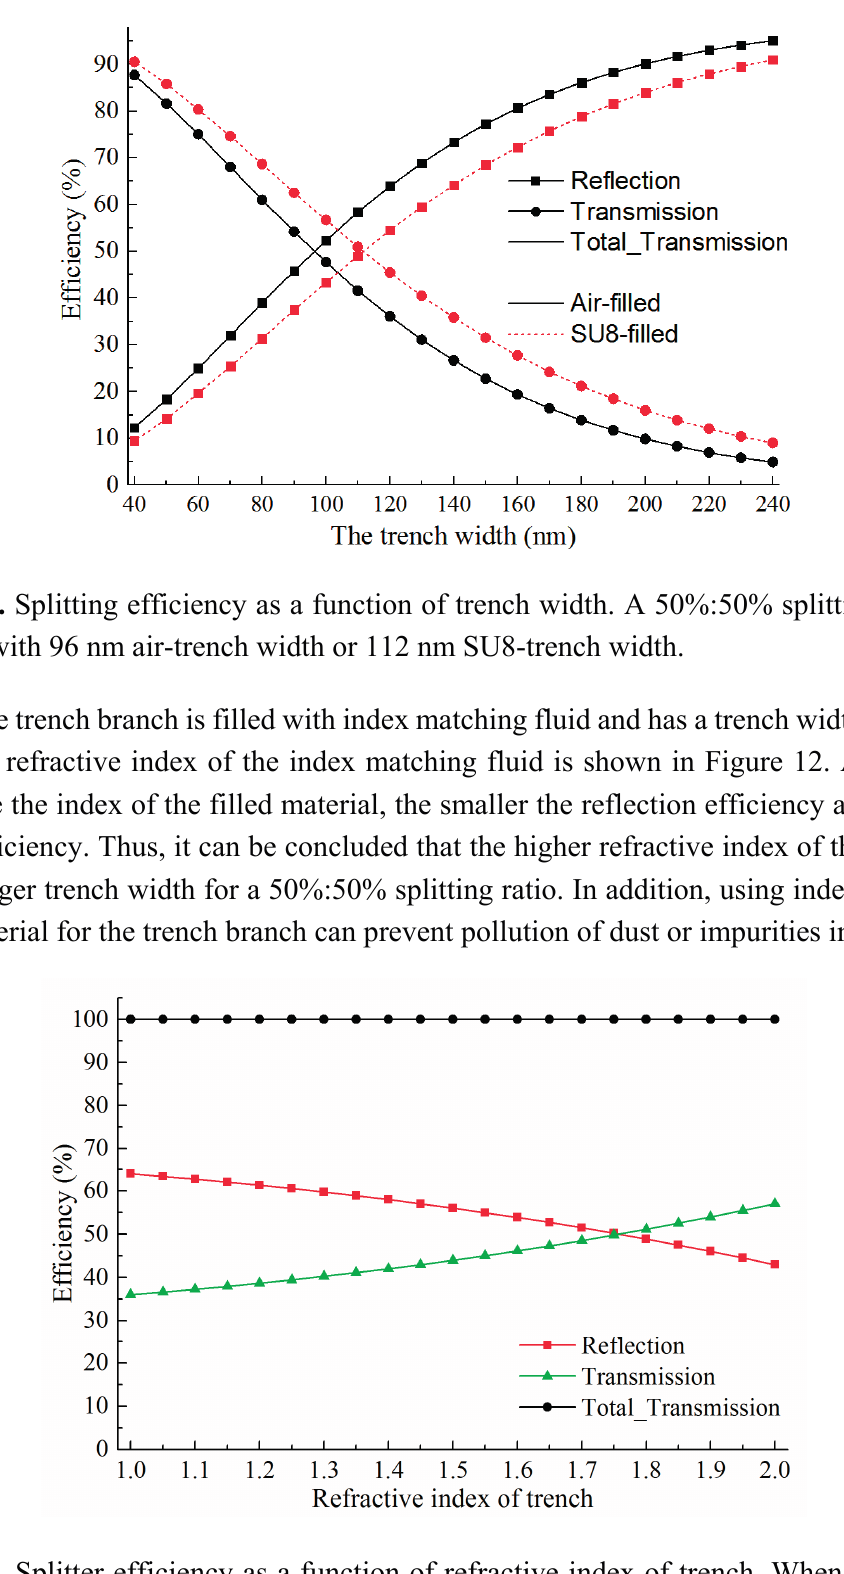
Figure 12. Splitter efficiency as a function of refractive index of trench. When the trench width is 0.12 μ m, a 50%:50% splitting ratio is achieved with the refractive index of